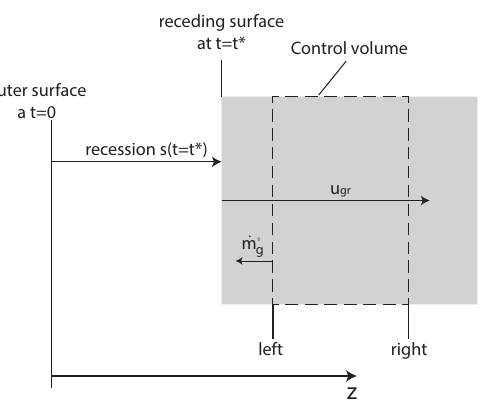
Figure 2. Schematic of a one-dimensional control volume describing the coordinates and labeling used in Equation